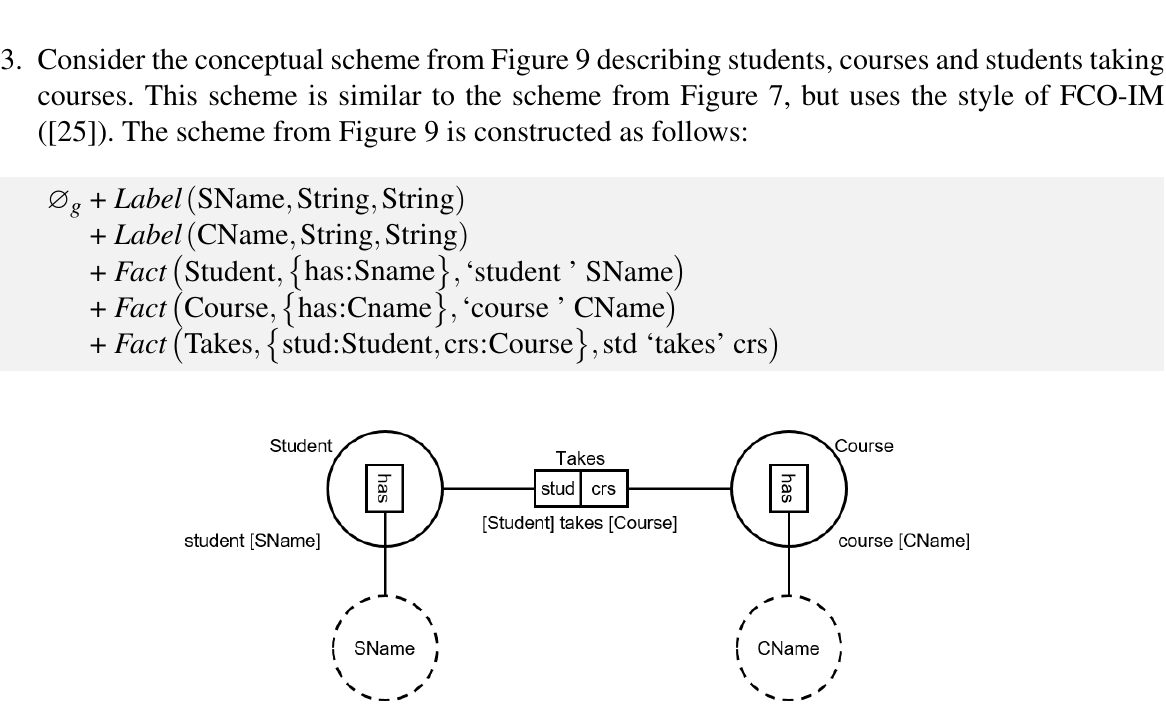
Figure 8. Companies and their products